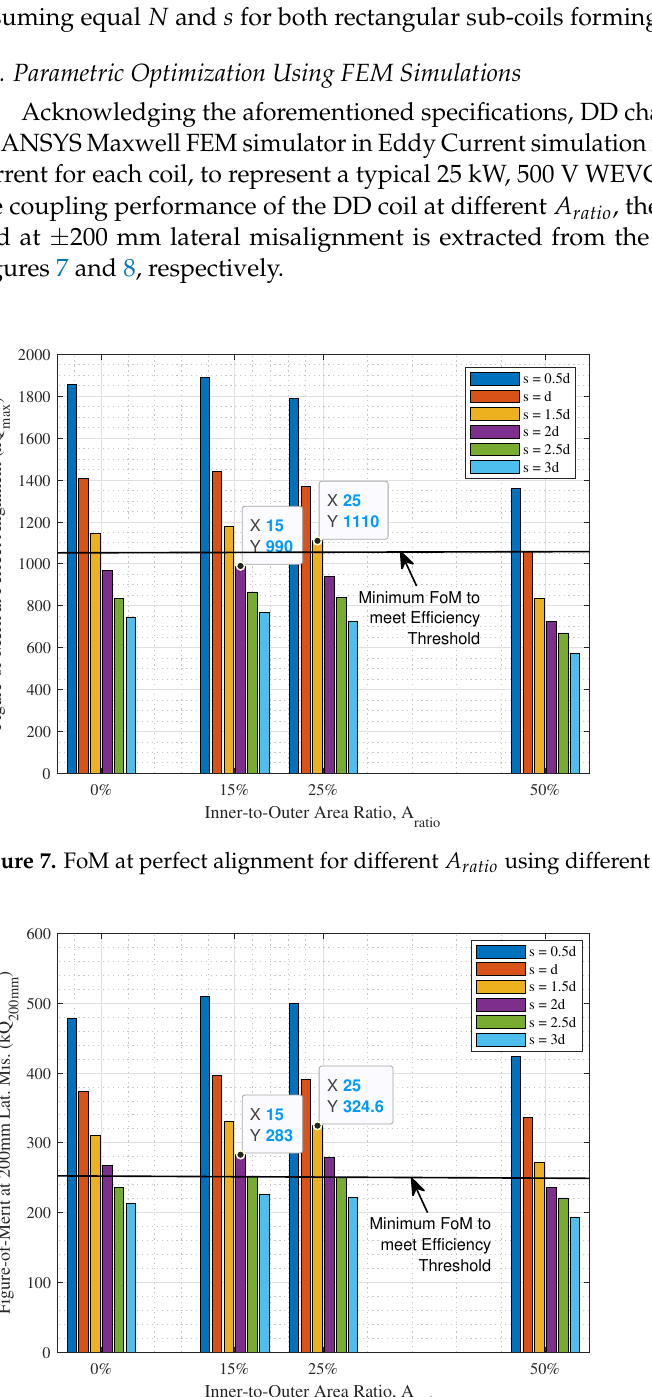
Figure 8. FoM at ± 200 mm lateral misalignment for different A ratio using different turn-to-turn spacing, s